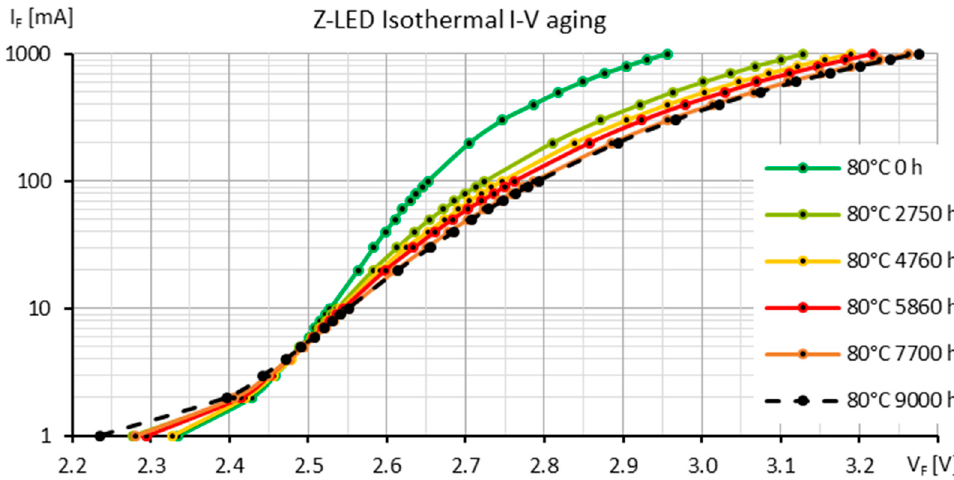
Figure 4. Shift of the forward voltage—forward current characteristics during the first 9000 h of a Luxeon Z LED sample (aged at 85 °C case temperature and 1 A forward current).